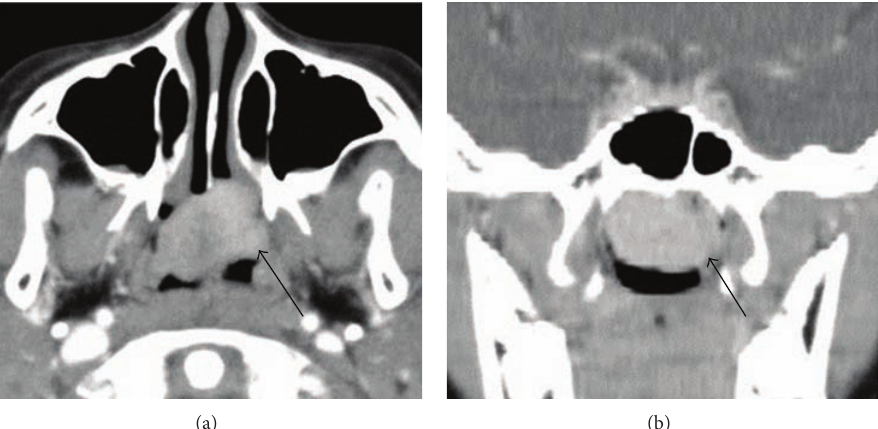
Figure 1: Axial (a) and coronal (b) computed tomography scans with contrast medium showing a soft tissue mass in the nasopharynx with homogeneous enhancement (arrows).